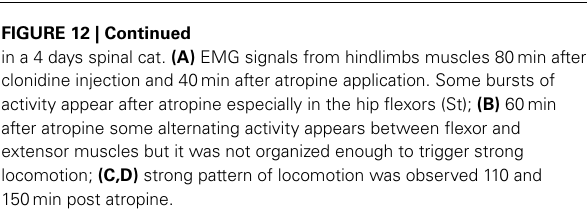
FACILITATION OF THE ENDOGENOUS CHOLINERGIC PROPRIOSPINAL